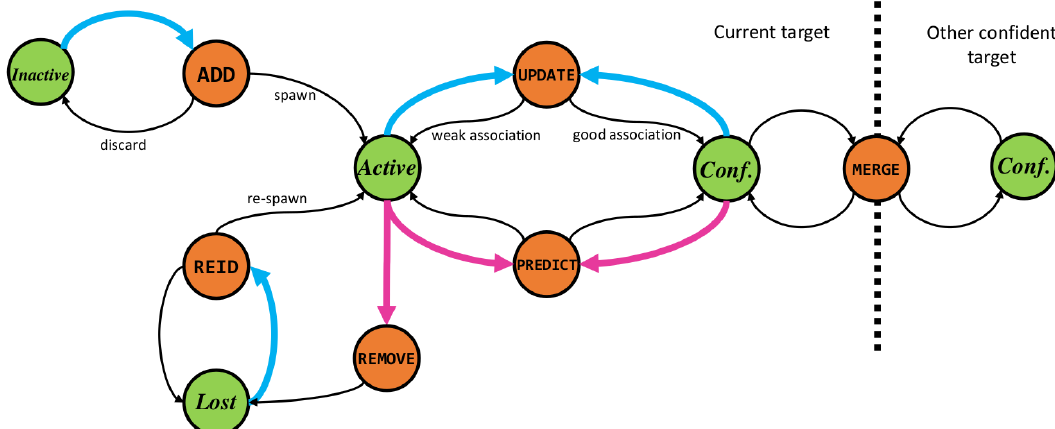
Figure 7. State diagram of a track life cycle. A track can change its state (green) by initiating different Actions (orange) based on the observation to target association solution L . Blue arrows indicate actions where observation can be associated, while magenta arrows indicate action taking with no available